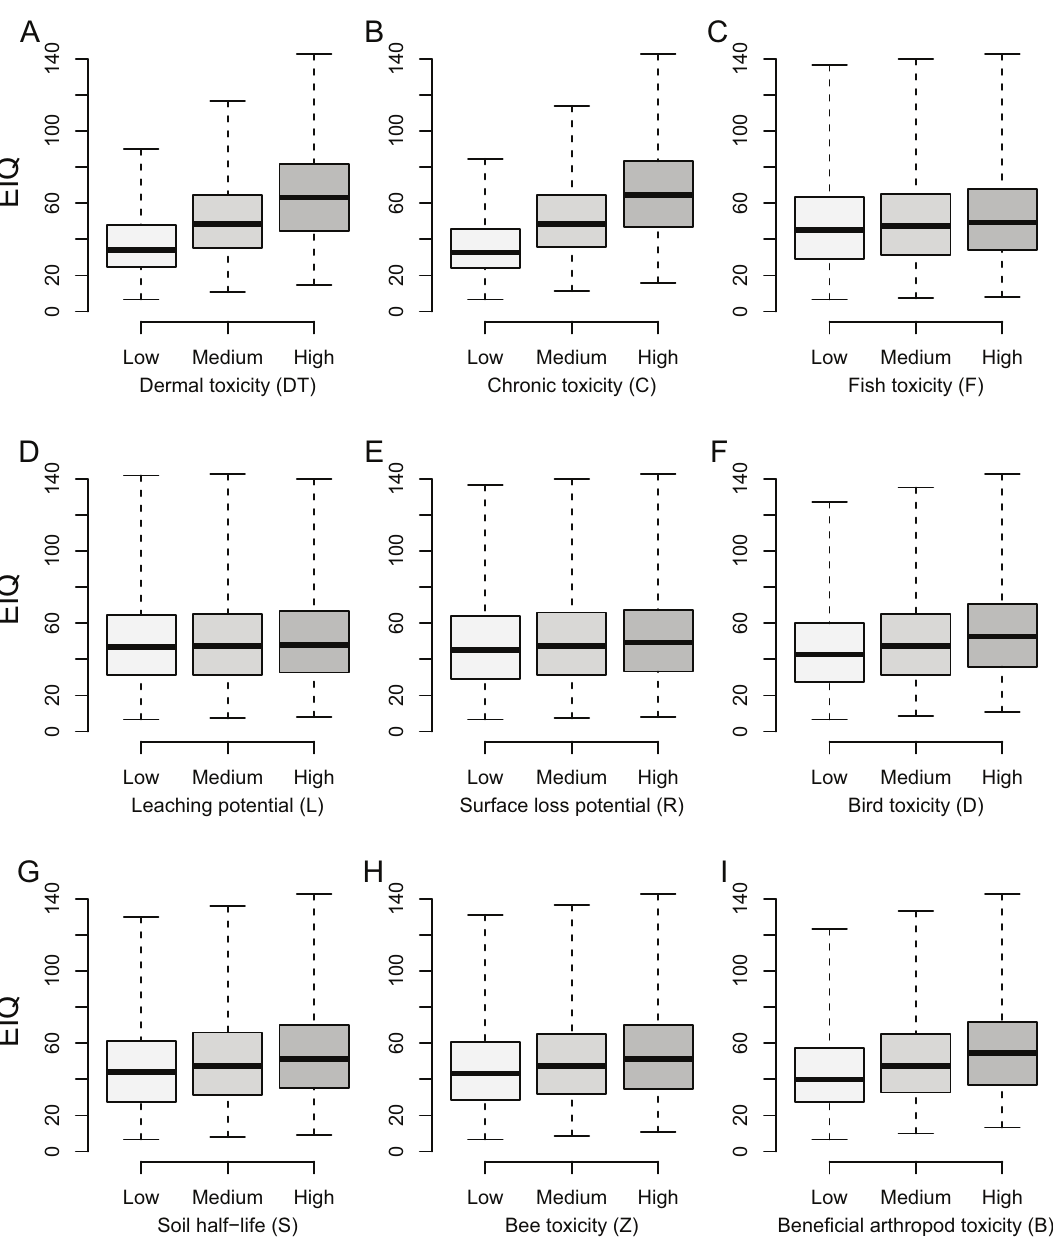
Fig 1. Simulated EIQ values for low, medium, and high risk categories for each risk factor used in the herbicide EIQ calculation (Eq 1). Dark bars represent median EIQ value, boxes enclose the first and third quartiles, and whiskers extend to minimum and maximum observed EIQ